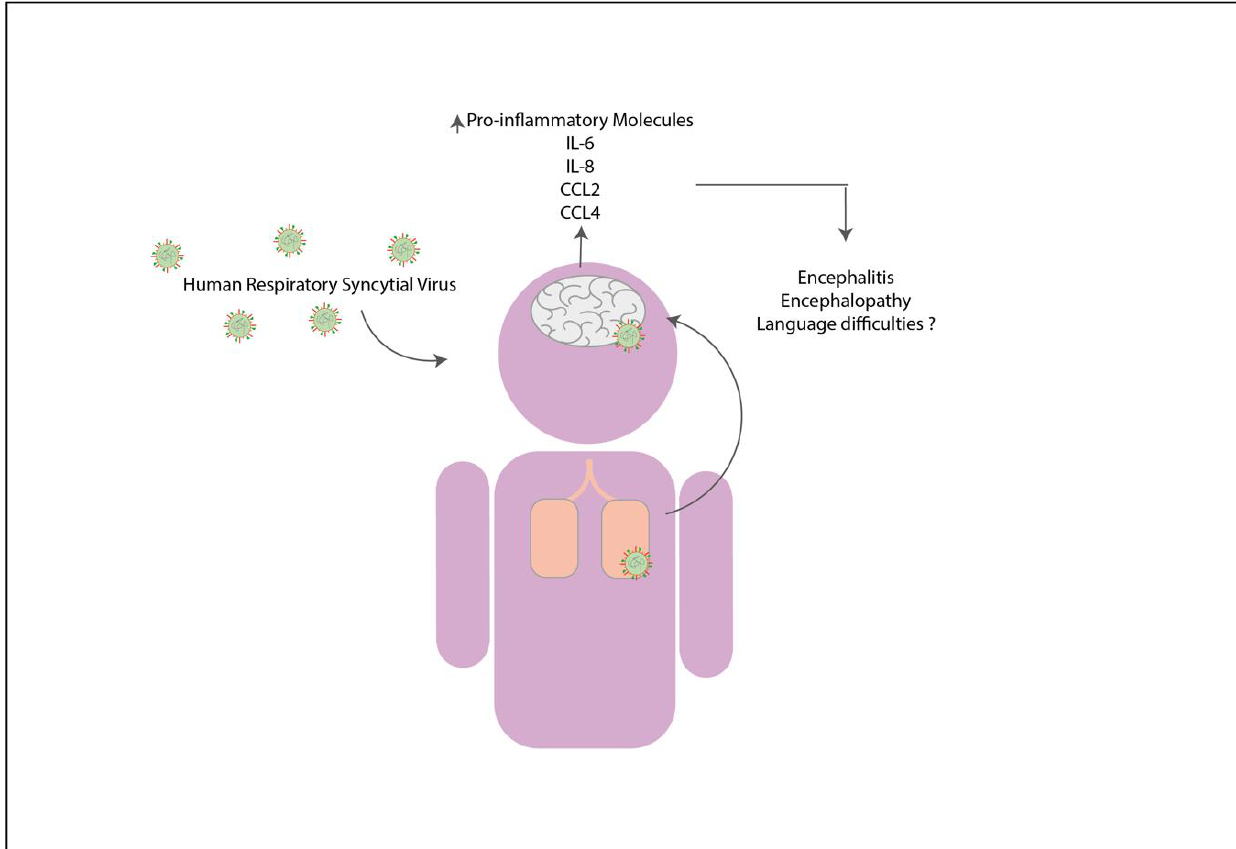
Figure 2. Human respiratory syncytial virus infection can cause neurologic consequences in patients. The respiratory infection with the respiratory syncytial virus can lead to neuroinflammation as a consequence of the elevated pro-inflammatory molecules such as IL-6, IL-8, CCL2, and CCL4 [150]. This increase can promote the development of neurologic symptoms such as encephalitis and encephalopathies [144–146].